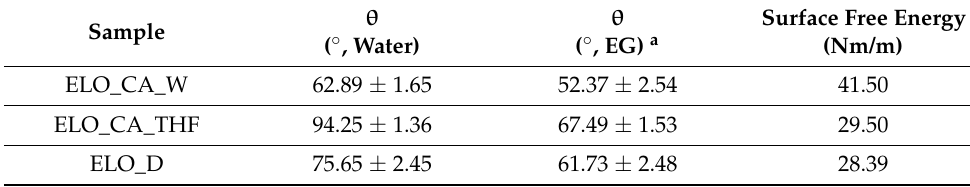
Table 4. CA results for the ELO-based samples.